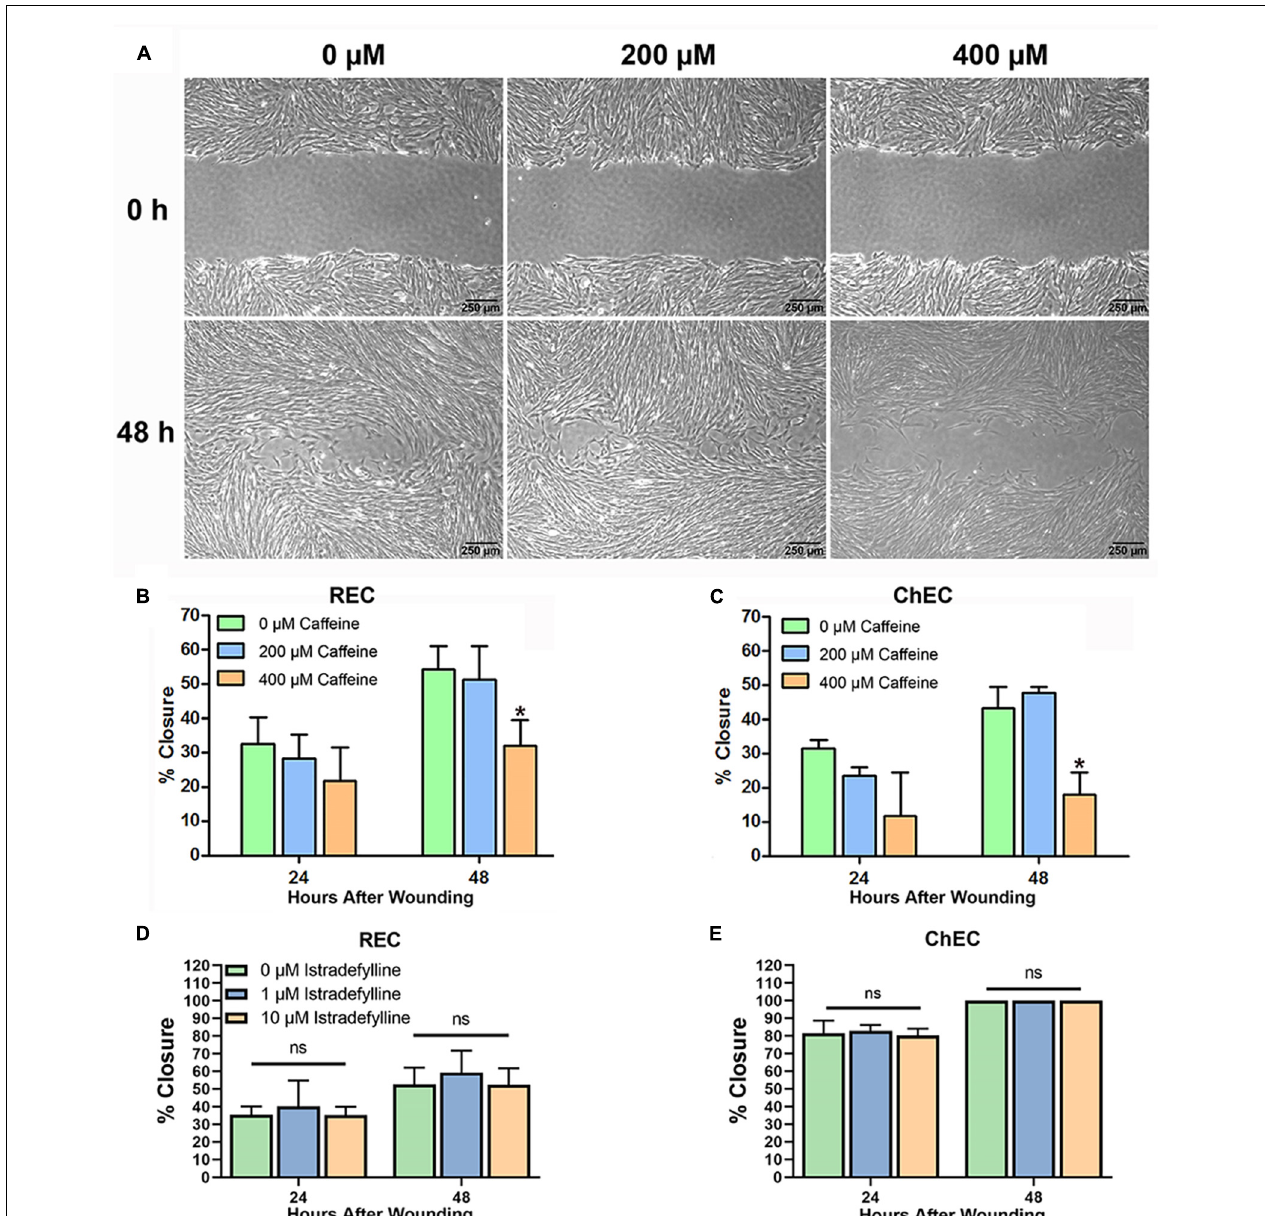
FIGURE 3 | Caffeine mitigates choroidal and retinal endothelial cell migration. Migration of retinal endothelial cells (REC) and choroidal endothelial cells (ChEC) incubated with caffeine was determined using a scratch wound assay and monitored by phase microscopy. The wound images from ChEC are shown in panel (A)